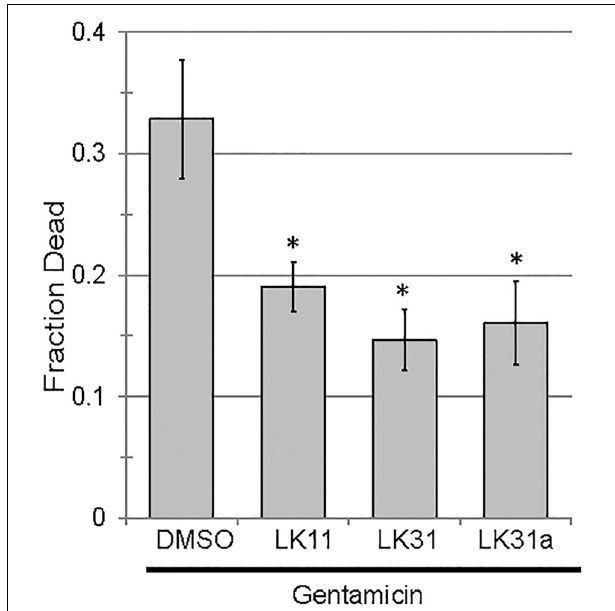
FIGURE 8 | Pyoverdine inhibitors synergize with antimicrobial gentamicin. Liquid Killing of C. elegans exposed to P. aeruginosa for 24 h and subsequently treated with either gentamicin alone or gentamicin in combination with an antivirulent (100 µ M). At least three biological replicates were performed. p -values were calculated using Student’s t -test, ∗ p <